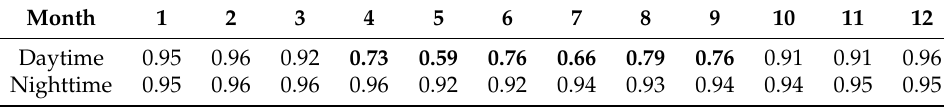
Table 2. Values of R 2 in daytime and nighttime cases for each month of 2015.